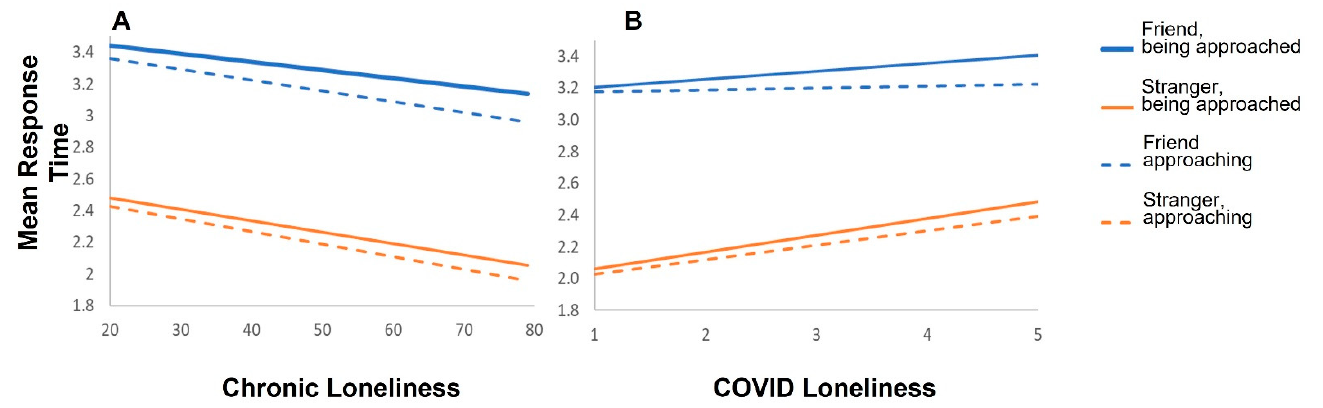
Figure 3. ( A ). Higher chronic loneliness is associated with a faster response time (preference for a greater distance) across all conditions. ( B ). The reverse pattern exists for COVID-19 loneliness. Higher COVID-19 loneliness is associated with a slower response time (preference for a smaller distance) in all conditions.